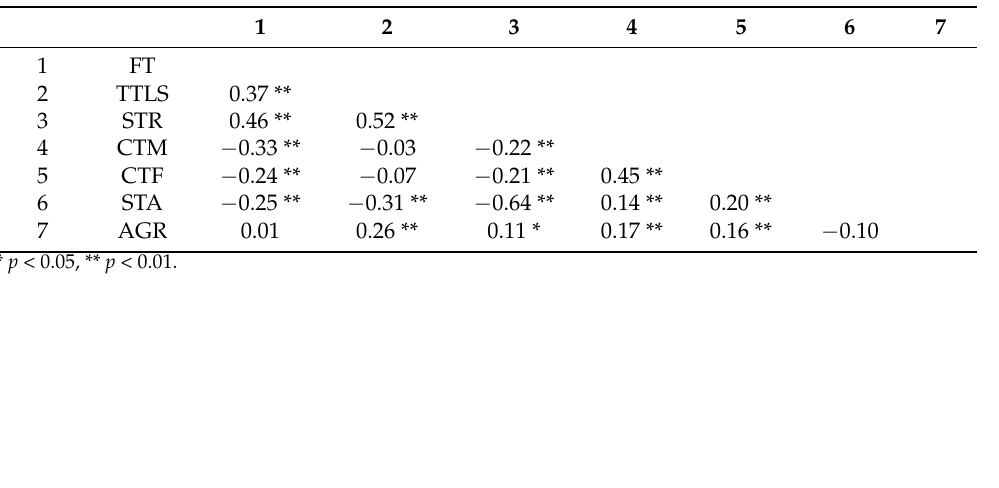
Table 3. Simple correlations between the individual variables (N =